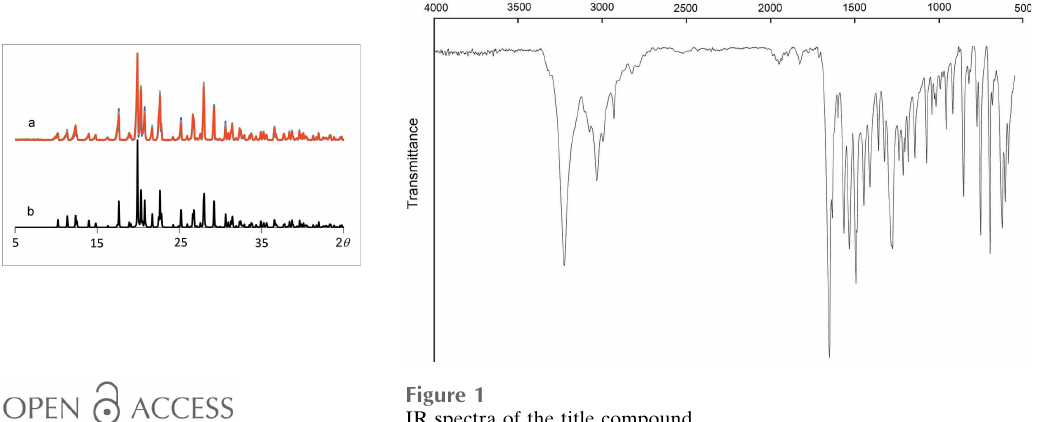
Figure 1 IR spectra of the title